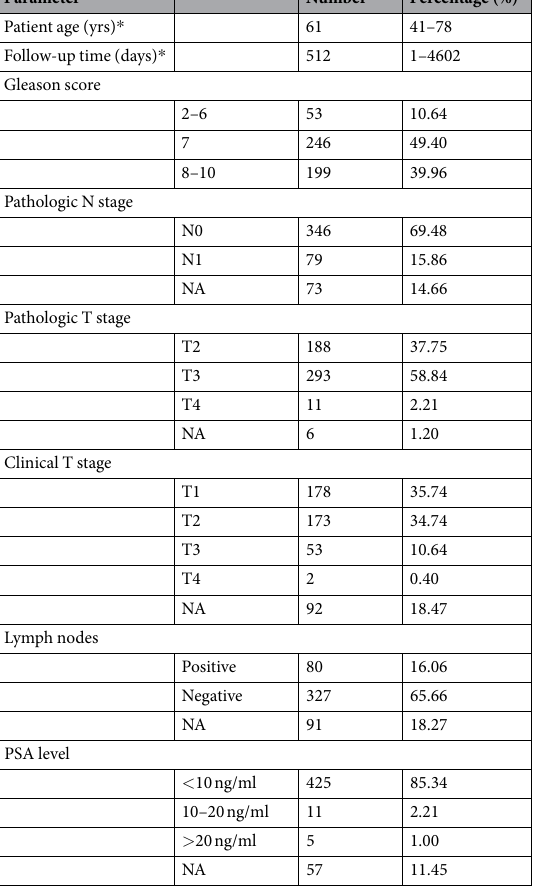
Table 1. Clinicopathological characteristics of 498 patient samples. For all of the variables used in this study, the number and percentage of tumor patients with the characteristic was given in this table, except for * median and range was given for the patient age and the follow up time.